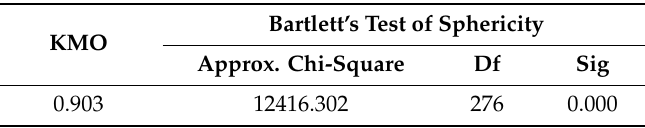
Table 4. KMO and Bartlett’s